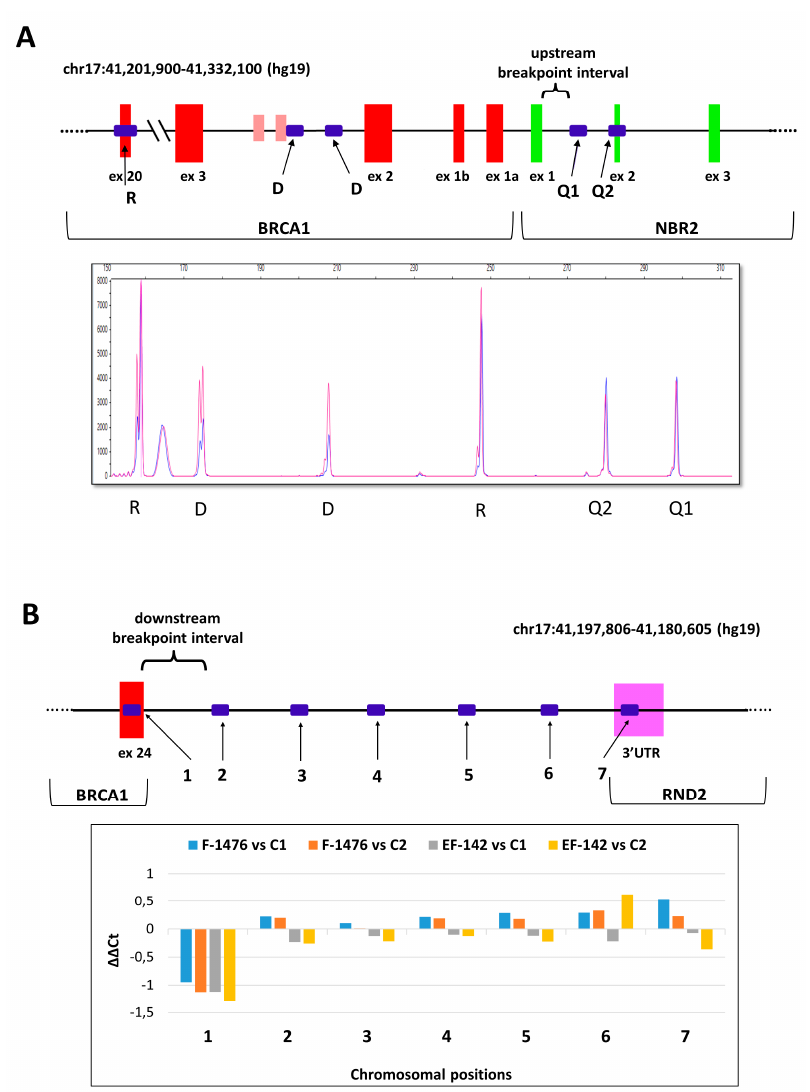
Figure 2. Narrowing down the breakpoint intervals with relative quantitation assays. Representative examples. ( A ): Quantitative multiplex PCR of short fluorescent fragments (QMPSF) assay of the BRCA1 del(ex1-3) sample with variant NG_005905.2:g.(88971_92304)_(102259_111450)del (blue) vs. control sample (red). R sign denotes amplicon peaks for biallelic control positions, D sign denotes amplicon peaks for monoallelic control positions. Q1 and Q2 denote queried positions of the upstream breakpoint interval, which was formerly confined to this region by multiplex ligation-dependent probe amplification (MLPA). Both query positions were biallelic, thus deletion breakpoint should be downstream of these positions. The inferred breakpoint interval is highlighted with brace on the graphic of the tested chromosomal region beneath the electropherogram. Red bars are exons for BRCA1 , green bars are exons for NBR2. ( B ): Real-time qPCR result for BRCA1 del(ex24) samples with variants LRG_292t1:c.5468-364_*749del (F-1476) and LRG_292t1:c.5506_*1383 + 36del (EF-142). Four bars per amplicon represent the ∆∆ Ct values of each BRCA1 del(ex24) samples relative to two di ff erent calibrators (C1 and C2). The standard errors of technical triplicates were below 5% for all measurements, so error bars are not shown. Position and numberings of the designed amplicon targets from BRCA1 exon 24 towards downstream region of the gene is depicted on the graphic of the tested chromosomal interval beneath the chart. Red bars are exons for BRCA1 , magenta bars are exons for RND2 . Only the amplicon designed for BRCA1 exon 24 showed deletion in both families, thus downstream deletion interval is restricted to the region between amplicons 1 and 2 (showed within